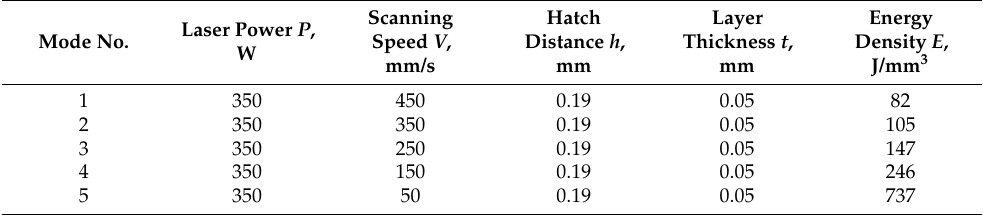
Table 3. Technological scanning parameters for selective laser melting (SLM) of Al–Si10–Mg and Cr18–Ni10–T bimetal. Mode No.